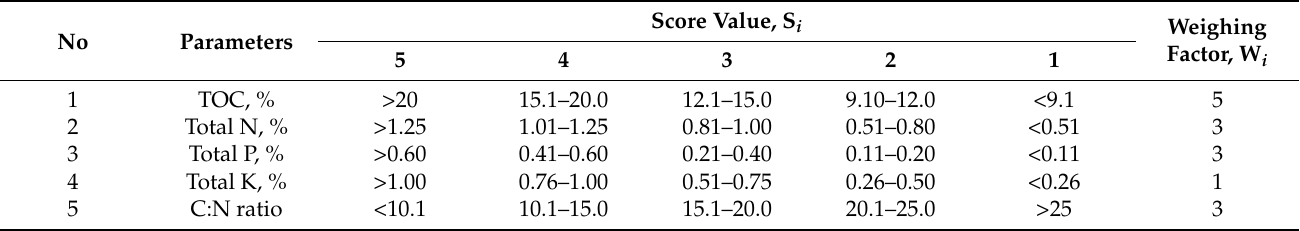
Table 1. Criteria for fertilizing index (FI) scoring (Source: [42,54]). Adapted with permission